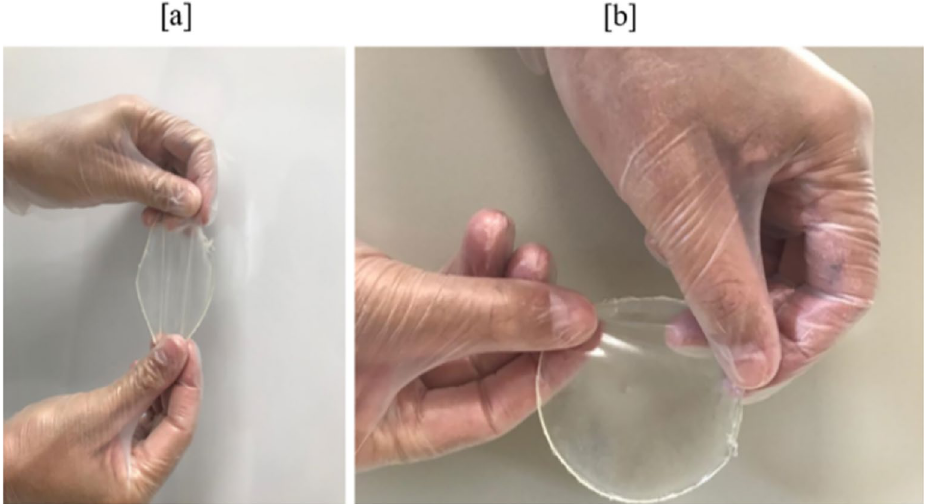
Figure 2. General aspects and visual appearance of the crystalline nanocellulose